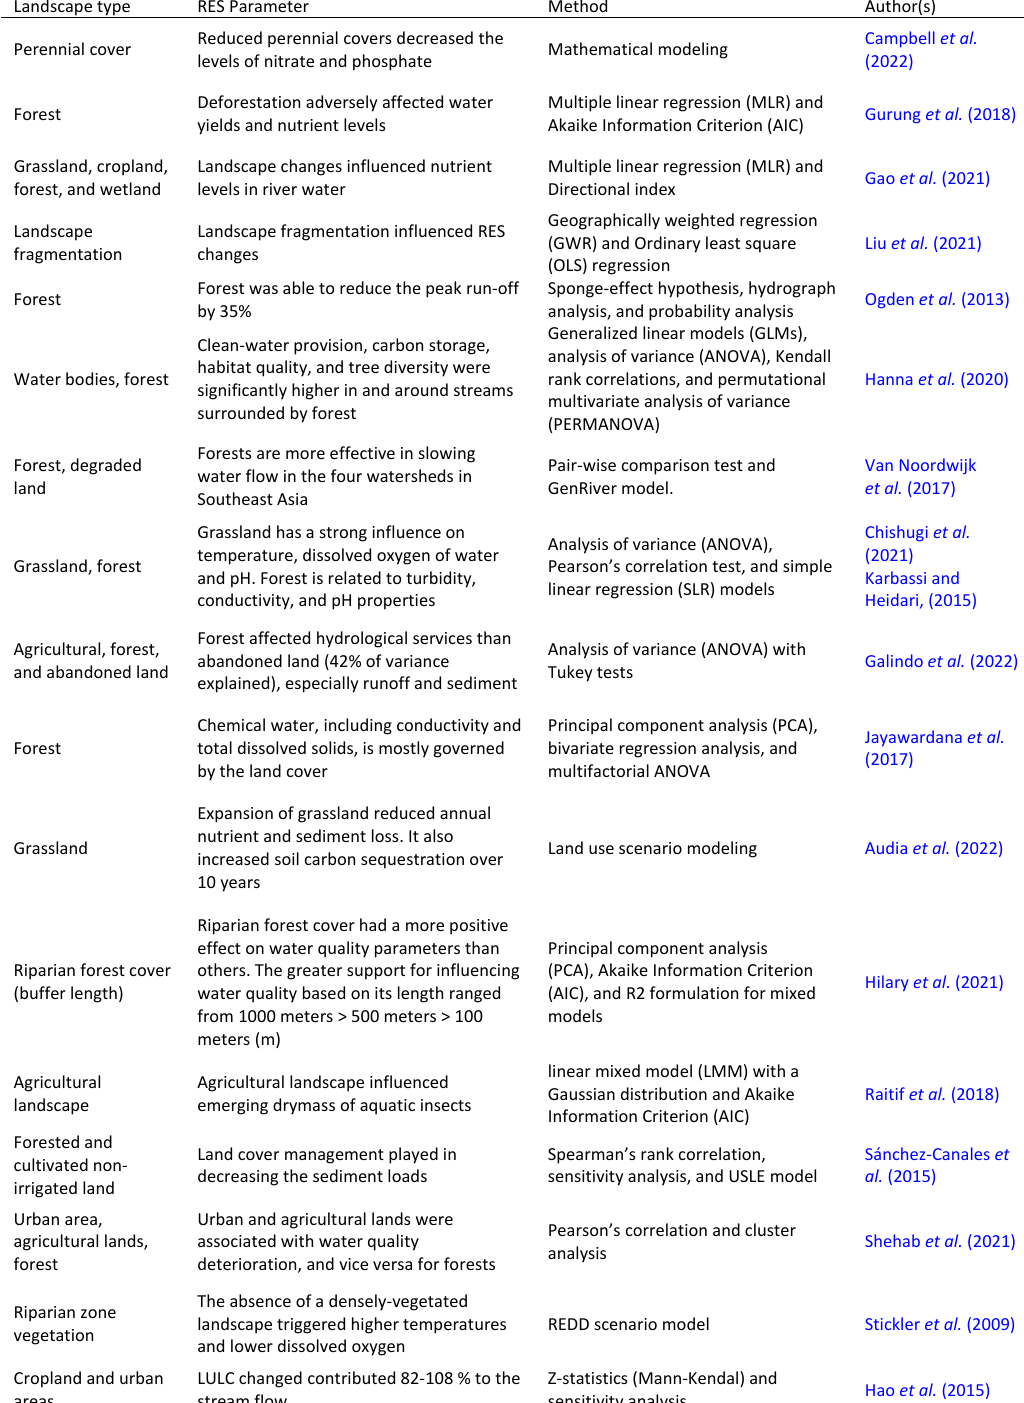
Table 4: Significant relation of landscape and RES